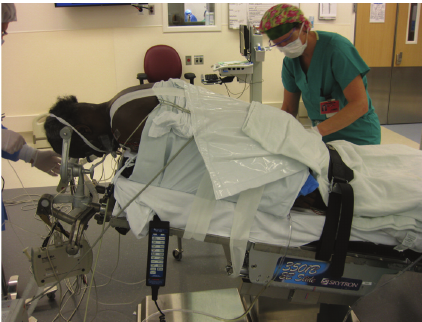
Figure 1: Photo demonstrating proper patient positioning. Patient is prone and the head is secured by Mayfield tongs without traction. The table is placed in the reverse Trendelenburg position. Shoulders are taped down and the neck is in slight flexion.